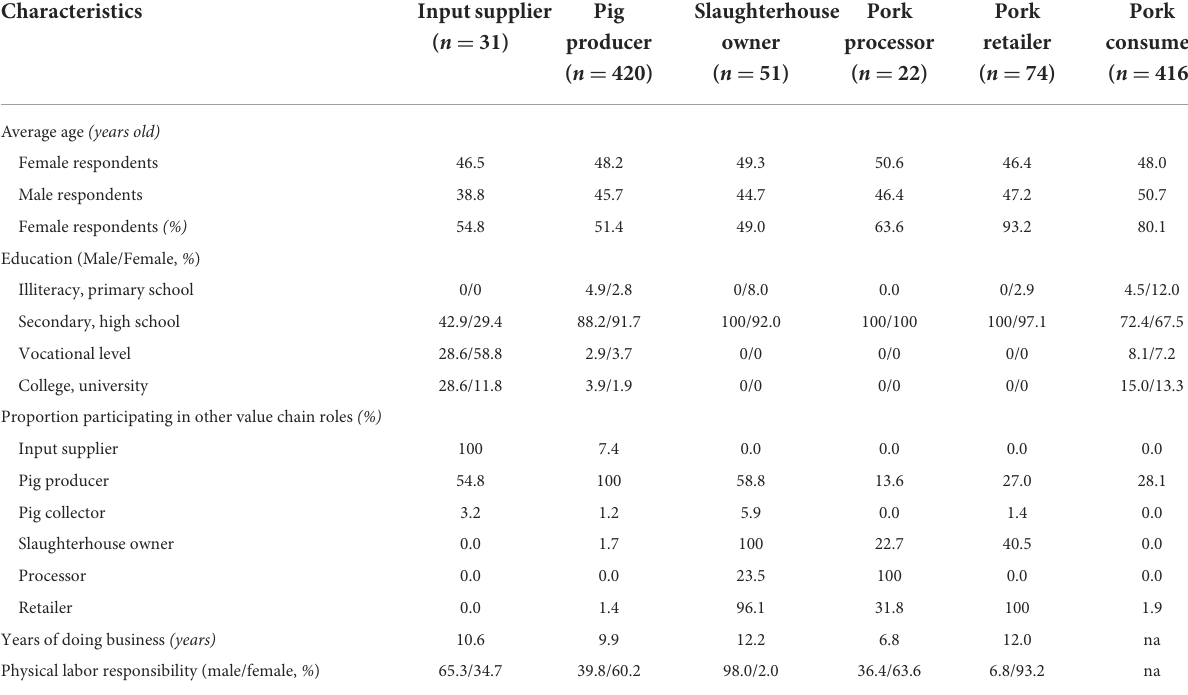
TABLE 1 Demographic characteristics of survey